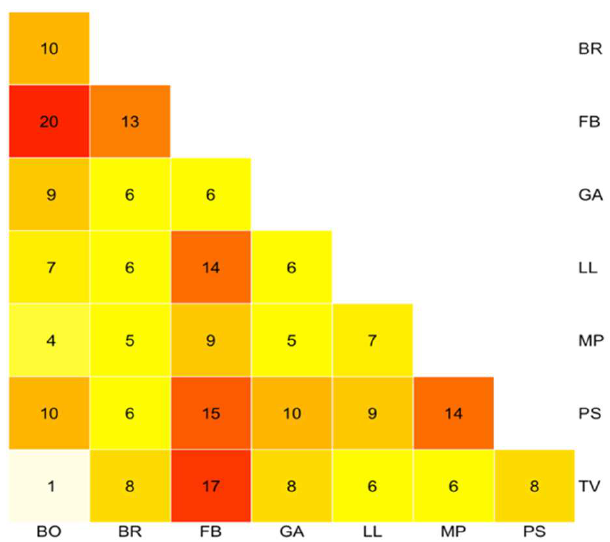
Figure 2. Heatmap of the pairwise comparisons of the 49 morphological characters for which we found statistically significant differences between population pairs in Armeria arenaria . Numbers inside the cells indicate the sum of statistically different characters. Colours are a function of the number of characters showing significant differences: whitish–yellow colours indicate that the pair is almost identical, whereas orange–red colours indicate that the pair shows several differences. AA = Apuan Alps, N Apennines; BO = Bobbio, N Apennines; BR = Brusson, Pennine Alps; FB = Fontainebleau, Île–de–France; GA = Gambolò, West Po Valley; LA = Libro Aperto; N Apennines; LL = Le Lauzet, Dauphiné Alps; MB = Marmagna–Braiola, N Apennines; MC = Monte Cusna, N Apennines; MP = Monte Prinzera, N Apennines; PS = Piana di Salmezza, Lombard Prealps; TV = Terme di Valdieri, Maritime Alps. Further population details are provided in Table 1 and Figure 6. Table 3. Confusion matrix of the LDA based on the 49 morphometric characters, assuming the current taxonomic hypothesis of Armeria arenaria subspecies as a priori groups, as proposed by Arrigoni [17]. Rows show the membership of each a priori established group, whereas columns show the membership predicted by the classification model.